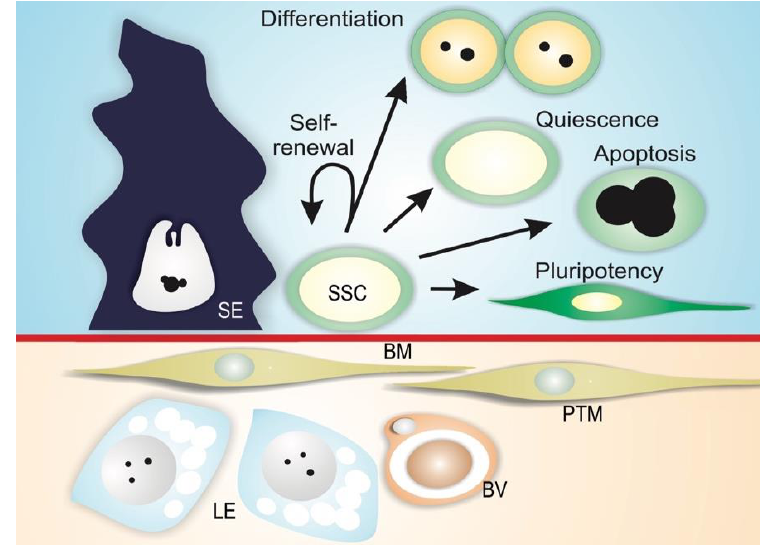
Figure 3. Mammalian SSC niche. Spermatogonial stem cells (SSC) reside along the basement membrane (BM) in proximity to interstitial Leydig cells (LE) and blood vessels (BV), and are in contact with Sertoli cells (SE). In this microenvironment, physical and paracrine interactions regulate SSC